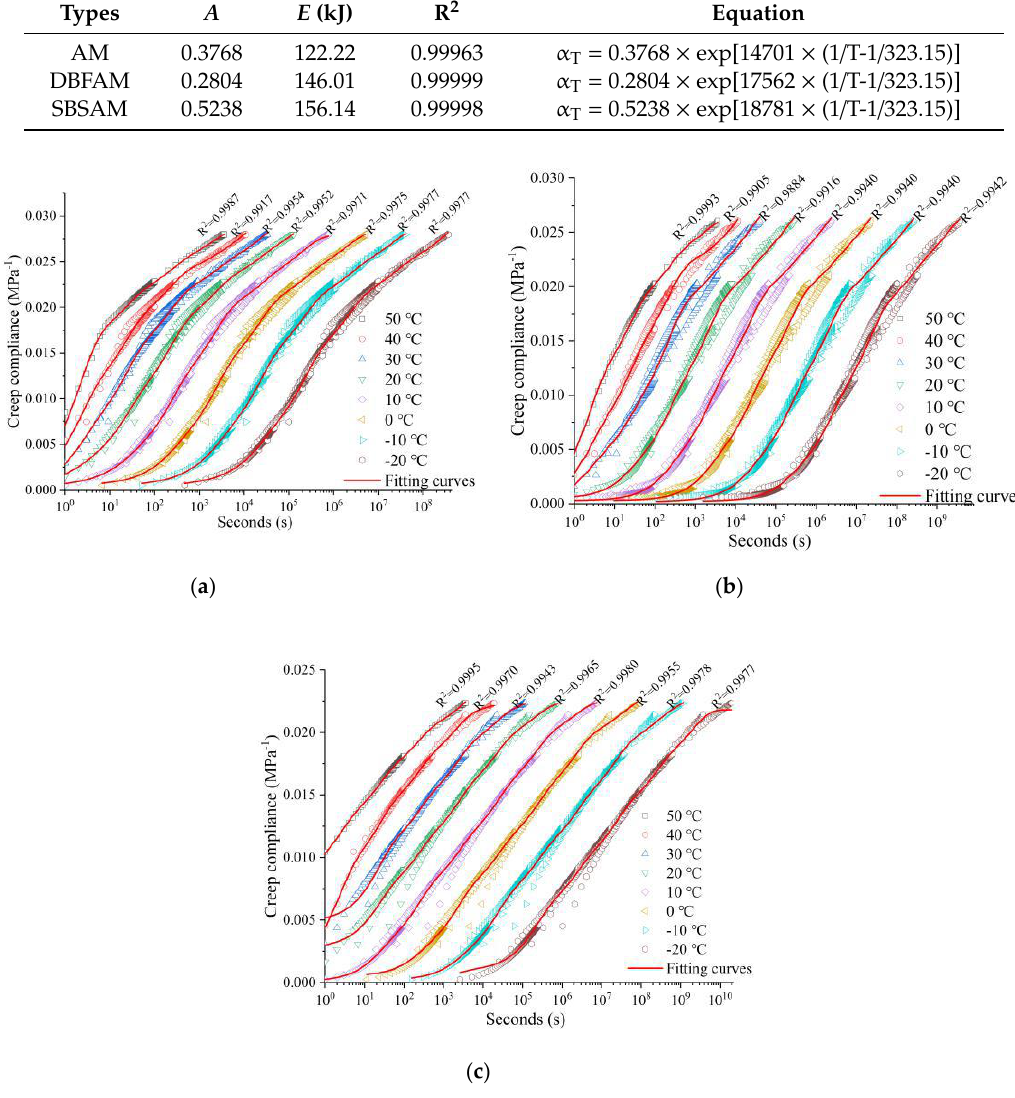
Figure 3. Creep compliances at different temperatures and the fitting results of generalized Kelvin model: ( a ) AM; ( b ) DBFAM; ( c ) SBSAM.